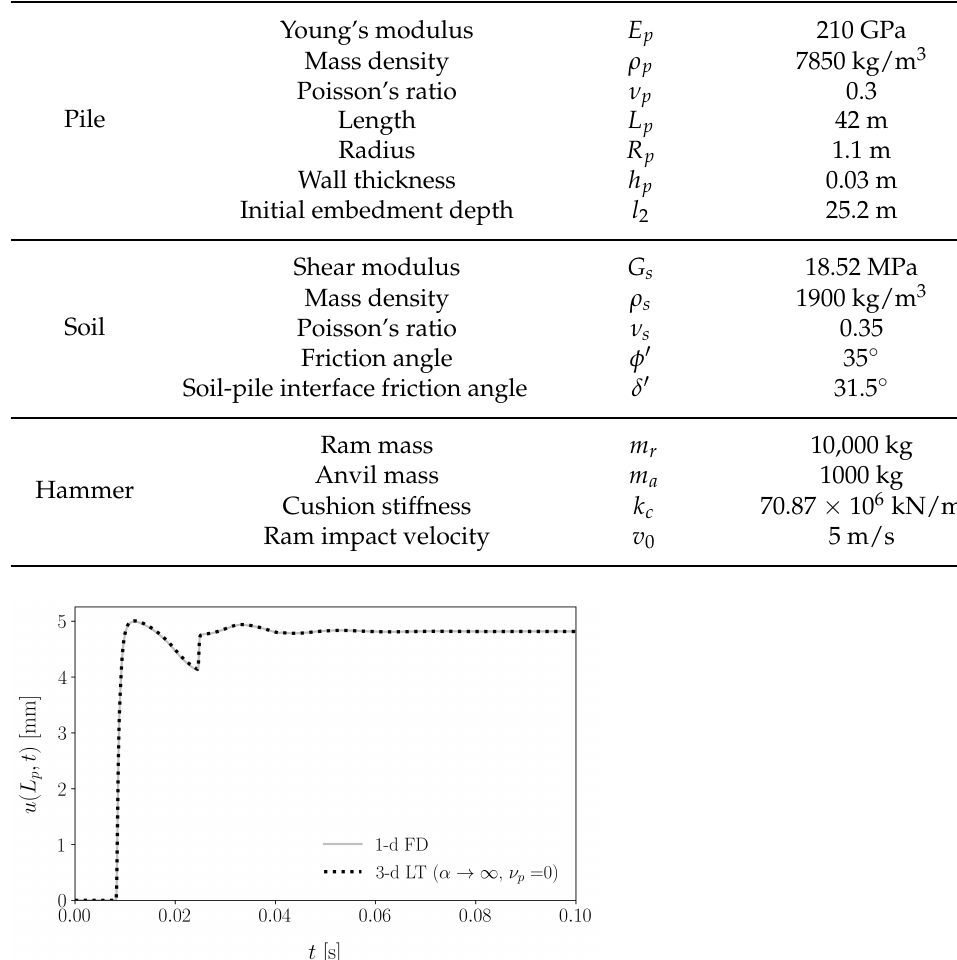
Figure 5. Axial tip displacement, u ( L p , t ) , comparison between the 1-d FD and the reduced 3-d LT model ( α → ∞ and ν p =